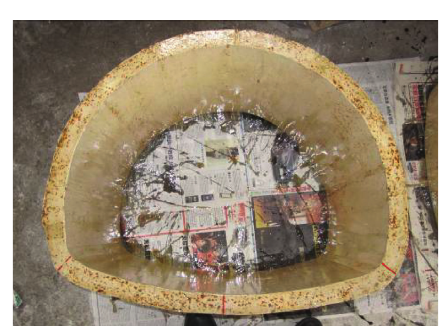
Figure 3: Lining